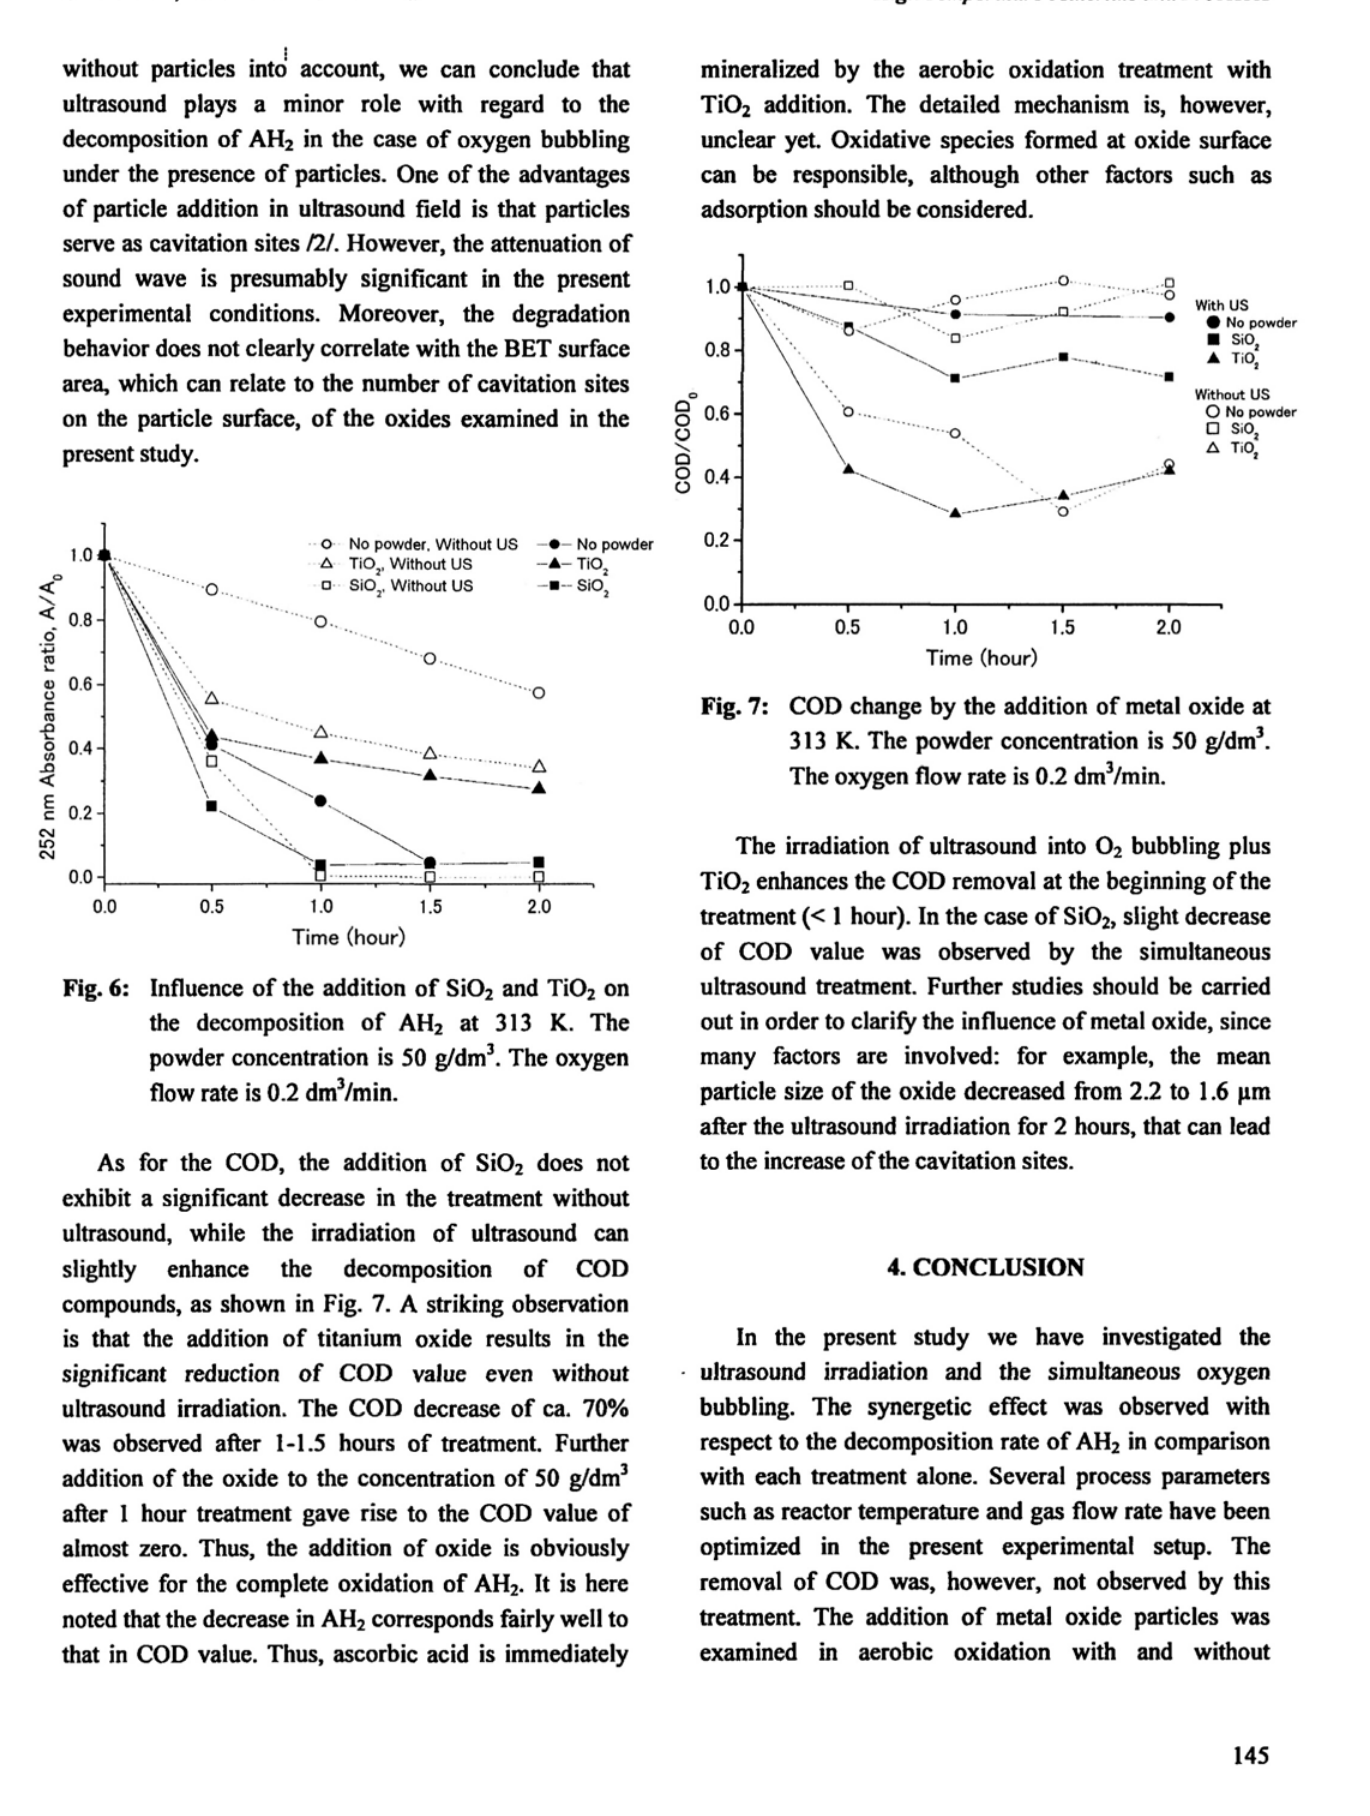
Fig. 6: Influence of the addition of SiO the decomposition of AH powder concentration is 50 g/dm 3 . The oxygen flow rate is 0.2 dnvVmin.